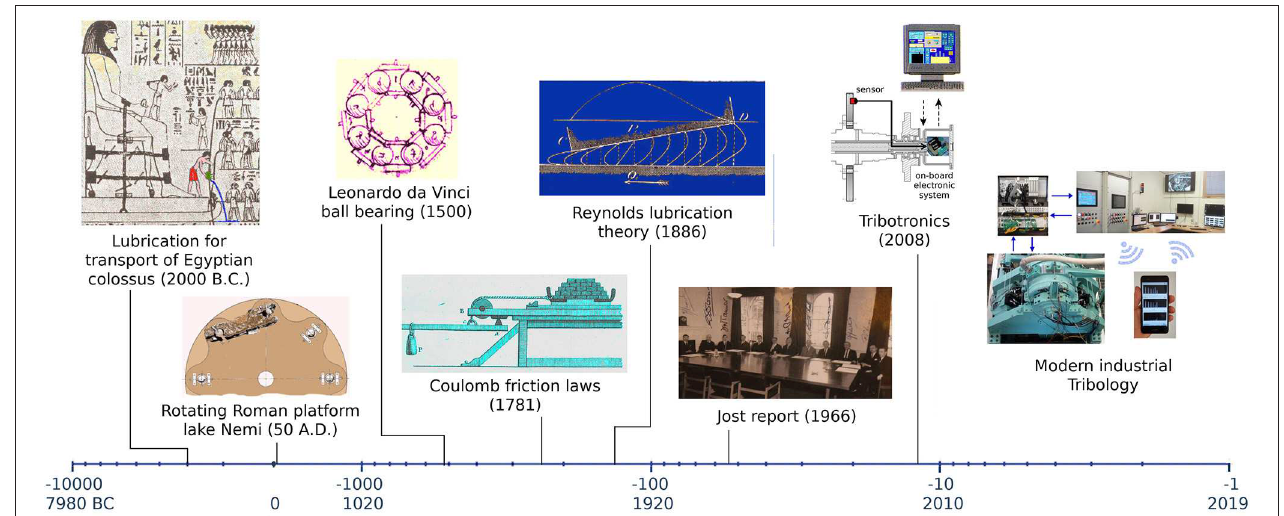
FIGURE 2 | The tribology evolutions. From the left: Egyptian bas-relief with a man pouring lubricants (adapted from Newberry and Fraser, 1895); Rotating platforms on Roman ships of lake Nemi (adapted from Ucelli, 1950); ball bearing of Leonardo da Vinci (adapted from da Vinci, 1493); experimental test on friction of Coulomb (adapted from Coulomb, 1782); principles of the hydrodynamic lubrication (Reynolds, 1886); meeting of the working group of the department of education and science lubrication engineering, London 1966; schematic drawing of a computer connected electronic system for measuring gear tooth temperature at the Research Center on Advanced Technology Mechanical Transmissions of the University of Pisa; smart experimental system at the laboratory for Rotordynamics and Bearings of the Research Center for the Mechanics of Turbomachinery of the University of